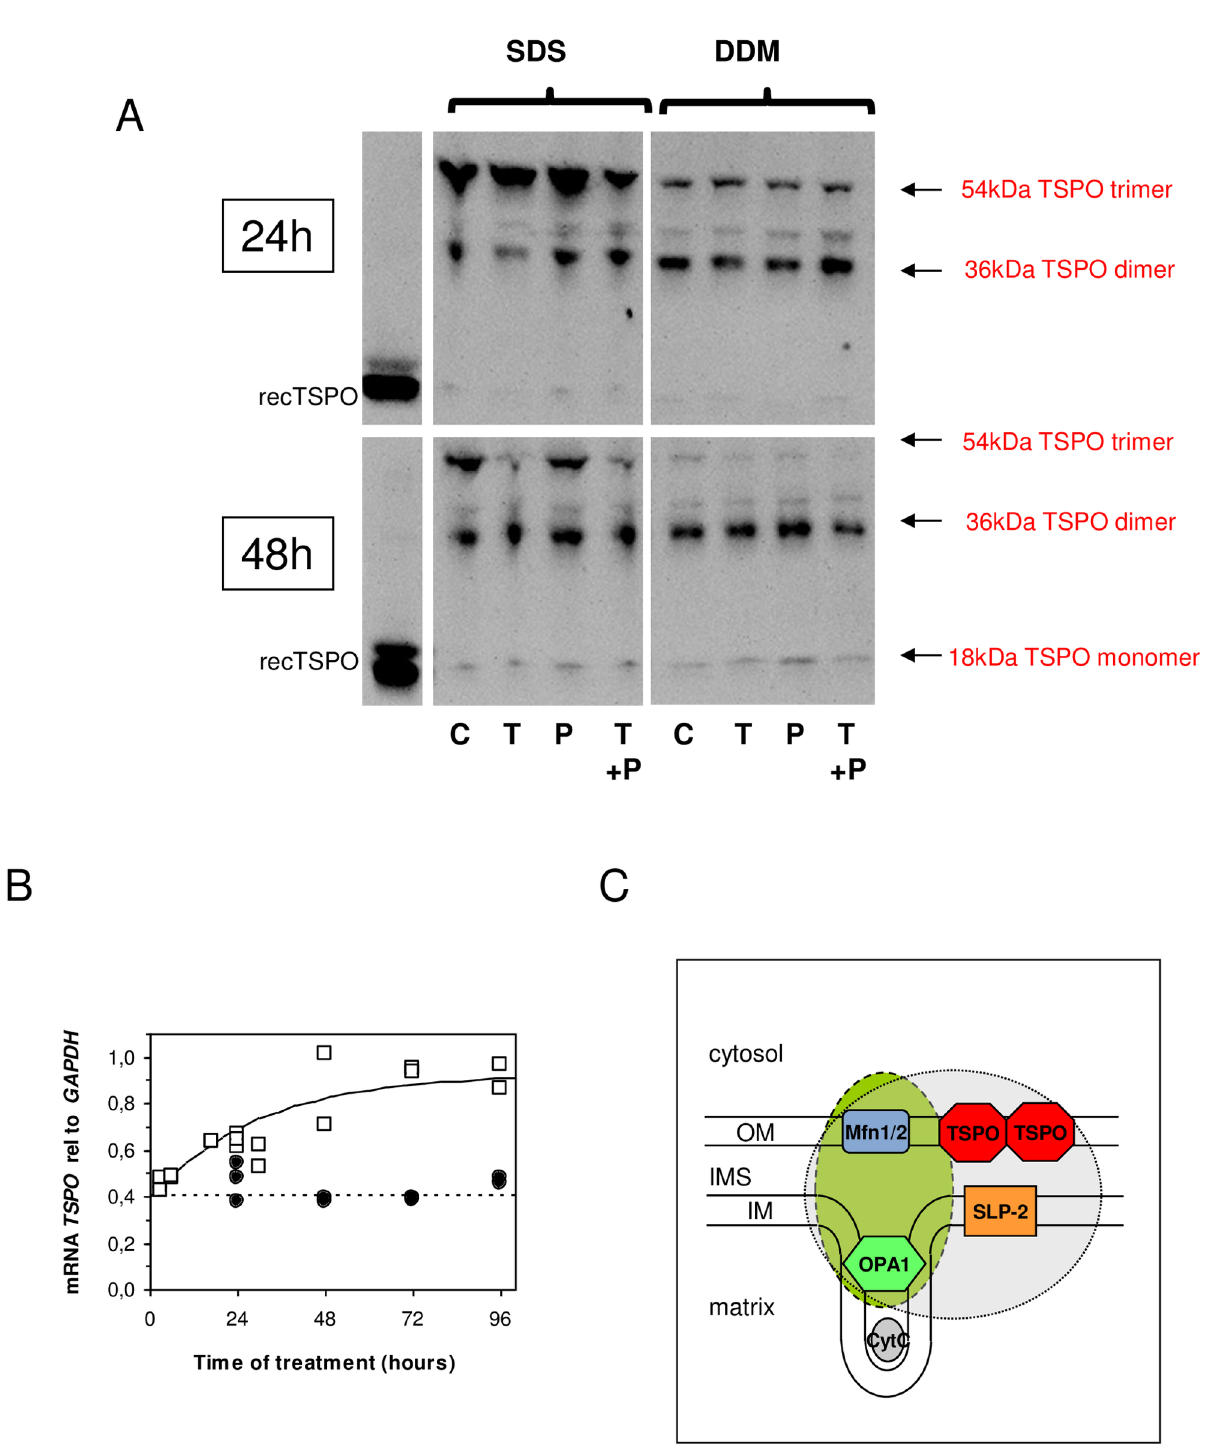
Fig 7. TSPO in HT-29 cells. (A) Western blot analysis of TSPO in SDS and DDM-solubilized mitochondrial membranes after 24 hours and 48 hours upon treatment with TNF [T], PK 11195 [P], both TNF and PK 11195 [T+P], and controls [C]. (B) TSPO mRNA expression relative to GAPDH as a function of the time of treatment with 10 ng/mL of TNF (open square) and controls without any treatment (closed circle). (D) Scheme of mitochondrial membrane proteins involved in different complexes revealed by partial solubilization with DDM (blue-colored circle) or digitonin (green-colored ellipse). The results are expressed as the means ± standard error of the